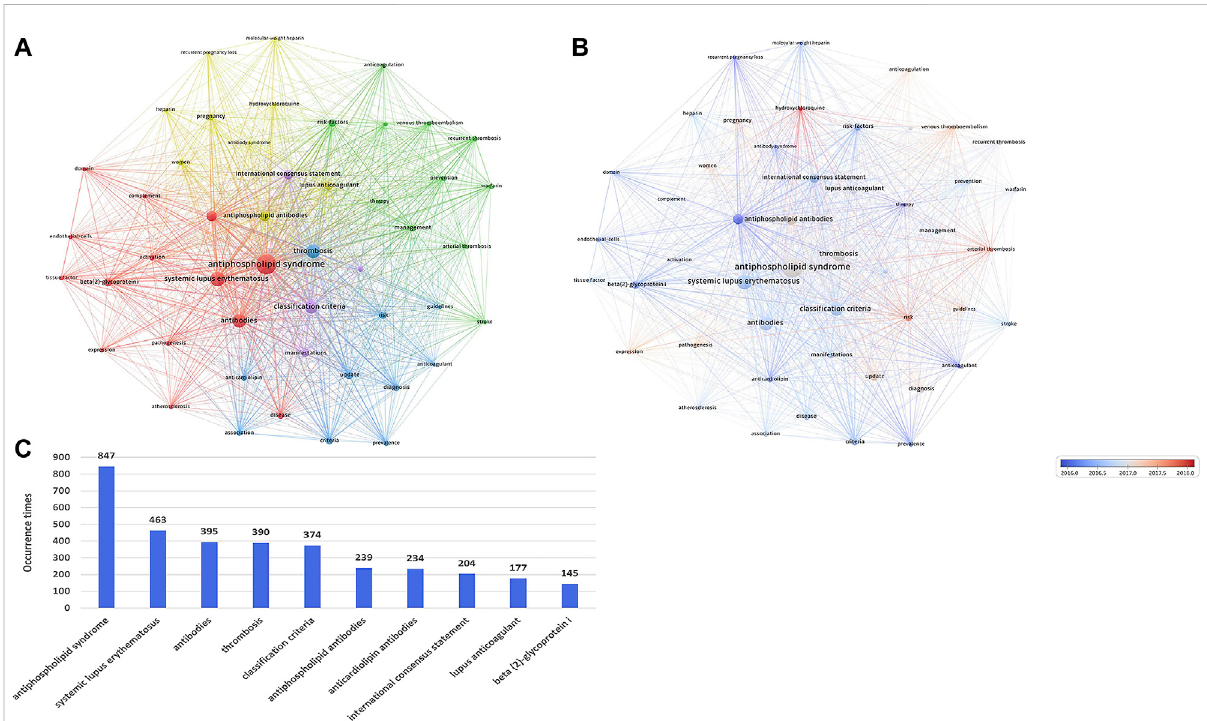
FIGURE 6 (A) Network clustering map of keywords ’ co-occurrence analysis based on VOSviewer. The minimum threshold for the number of keyword frequencies is 40. Keywords were divided into 5 clusters: cluster 1 (red), cluster 2 (green), cluster 3 (blue), cluster 4 (yellow), and cluster 5 (purple). Each keyword is represented as a node, and the node size is proportional to the frequency. The line between nodes denotes a co-occurrence relationship. The distance between nodes denotes the degree of relevancy, and the closer the distance, the higher the degree of relevancy. (B) Overlay map of keywords ’ co-occurrence analysis based on VOSviewer. The node color denotes the corresponding average occurrence time according to the color gradient in the lower right corner. Nodes displayed in blue represent keywords that appear relatively early, while nodes displayed in red represent keywords that appear later. (C) Top 20 keywords with the highest occurrence